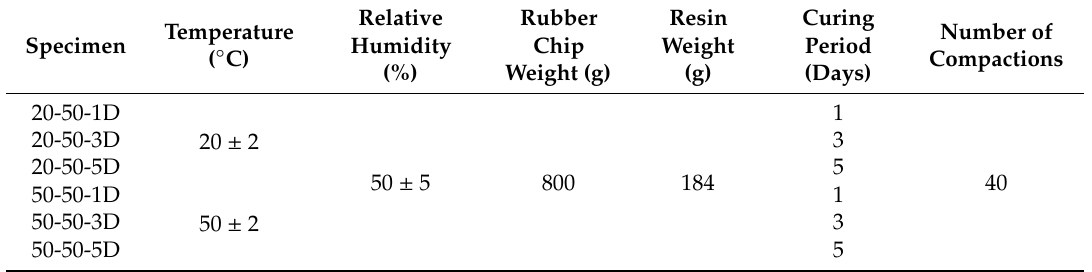
Table 2. Test variables employed to evaluate the e ff ects of the curing period.